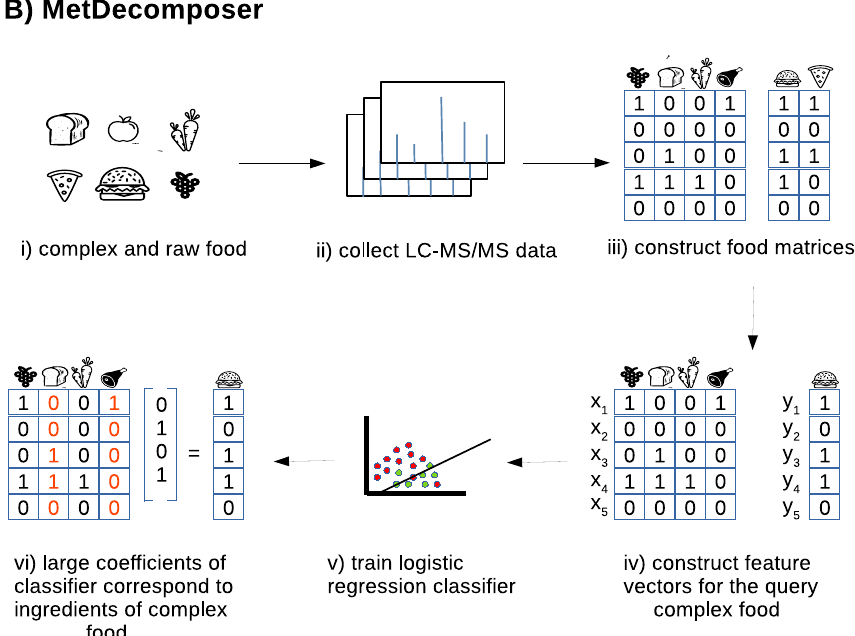
Figure 1. MetSummarizer pipeline. ( A ) MetClassifier, (i) starts with reference mass spectra of environmental/ host-oriented samples. (ii) Mass spectrometry feature and metadata matrices are formed. (iii) A logistic regression classifier is trained for predicting phenotype from mass spectrometry features. (iv) Mass spectrometry feature vector is formed for query sample. (v) The classifier predicts phenotypes for query sample. ( B ) In MetDecomposer, starting from (i) complex and raw foods, (ii) LC-MS-MS data is collected. (iii) Matrices corresponding to the spectral features of raw and complex foods are formed. Then in order to find composition of a complex food, (iv) construct a feature vector for the complex food sample. (v) Train a logistic regression classifier to identify raw ingredients of the complex food. (vi) Large coefficients of the classifier correspond to ingredients of the complex food (i.e if the i th coefficient of classifier is large, then the i th ingredient in raw food matrix is